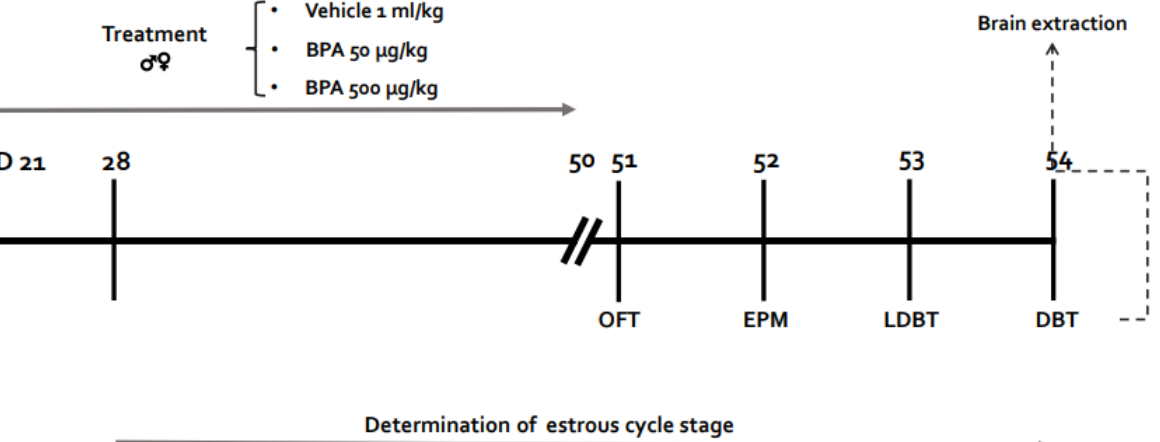
Figure 1. Experimental design. Timeline representing the experimental design followed in this study. OFT: Open field test; EPM: Elevated plus maze; LDBT: Light dark box test; DBT: Defensive burying test; PND: Postnatal day.